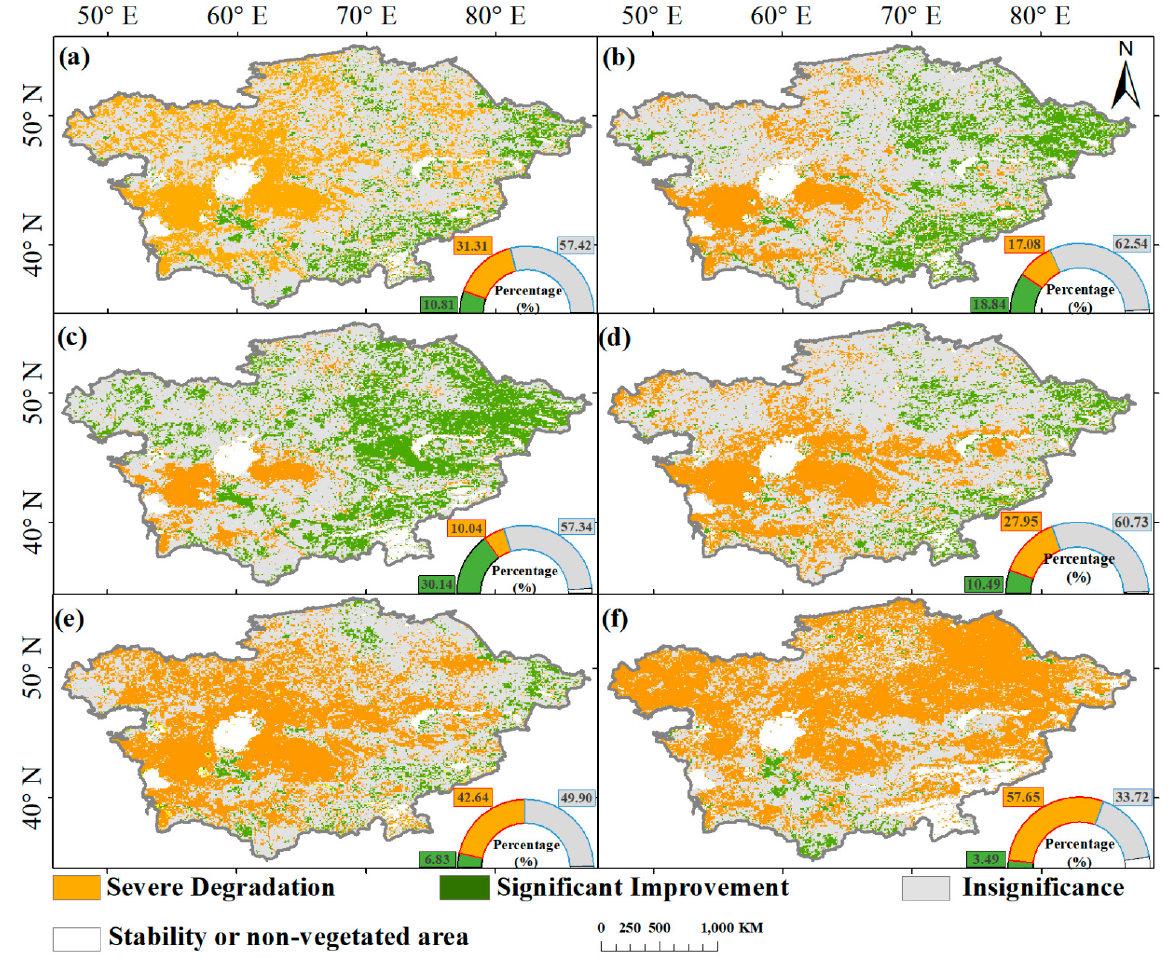
Figure 2. Spatial distribution of the variation tendency per year ( a ) and growing season ( b ), and for spring ( c ), summer ( d ), autumn ( e ), and winter ( f ), in the NDVI in Central Asia. At the seasonal scale, the spatial distribution of vegetation trends exhibited significant differences. The vegetation increased in a large part of the total study area (65.6%), and only 17.08% of the vegetative area presented significant degradation in spring (Figure 2c). Most pixels showing significant degradation were observed in western and middle Central Asia in summer and autumn, comprising 27.95% and 42.64% of the total study area, respectively (Figure 2d,f). Winter showed the highest proportion of degradation (57.65%) among the four seasons, and only a small area (3.49%) presented improvement—the irrigation areas distributed along rivers (Figure 2e).